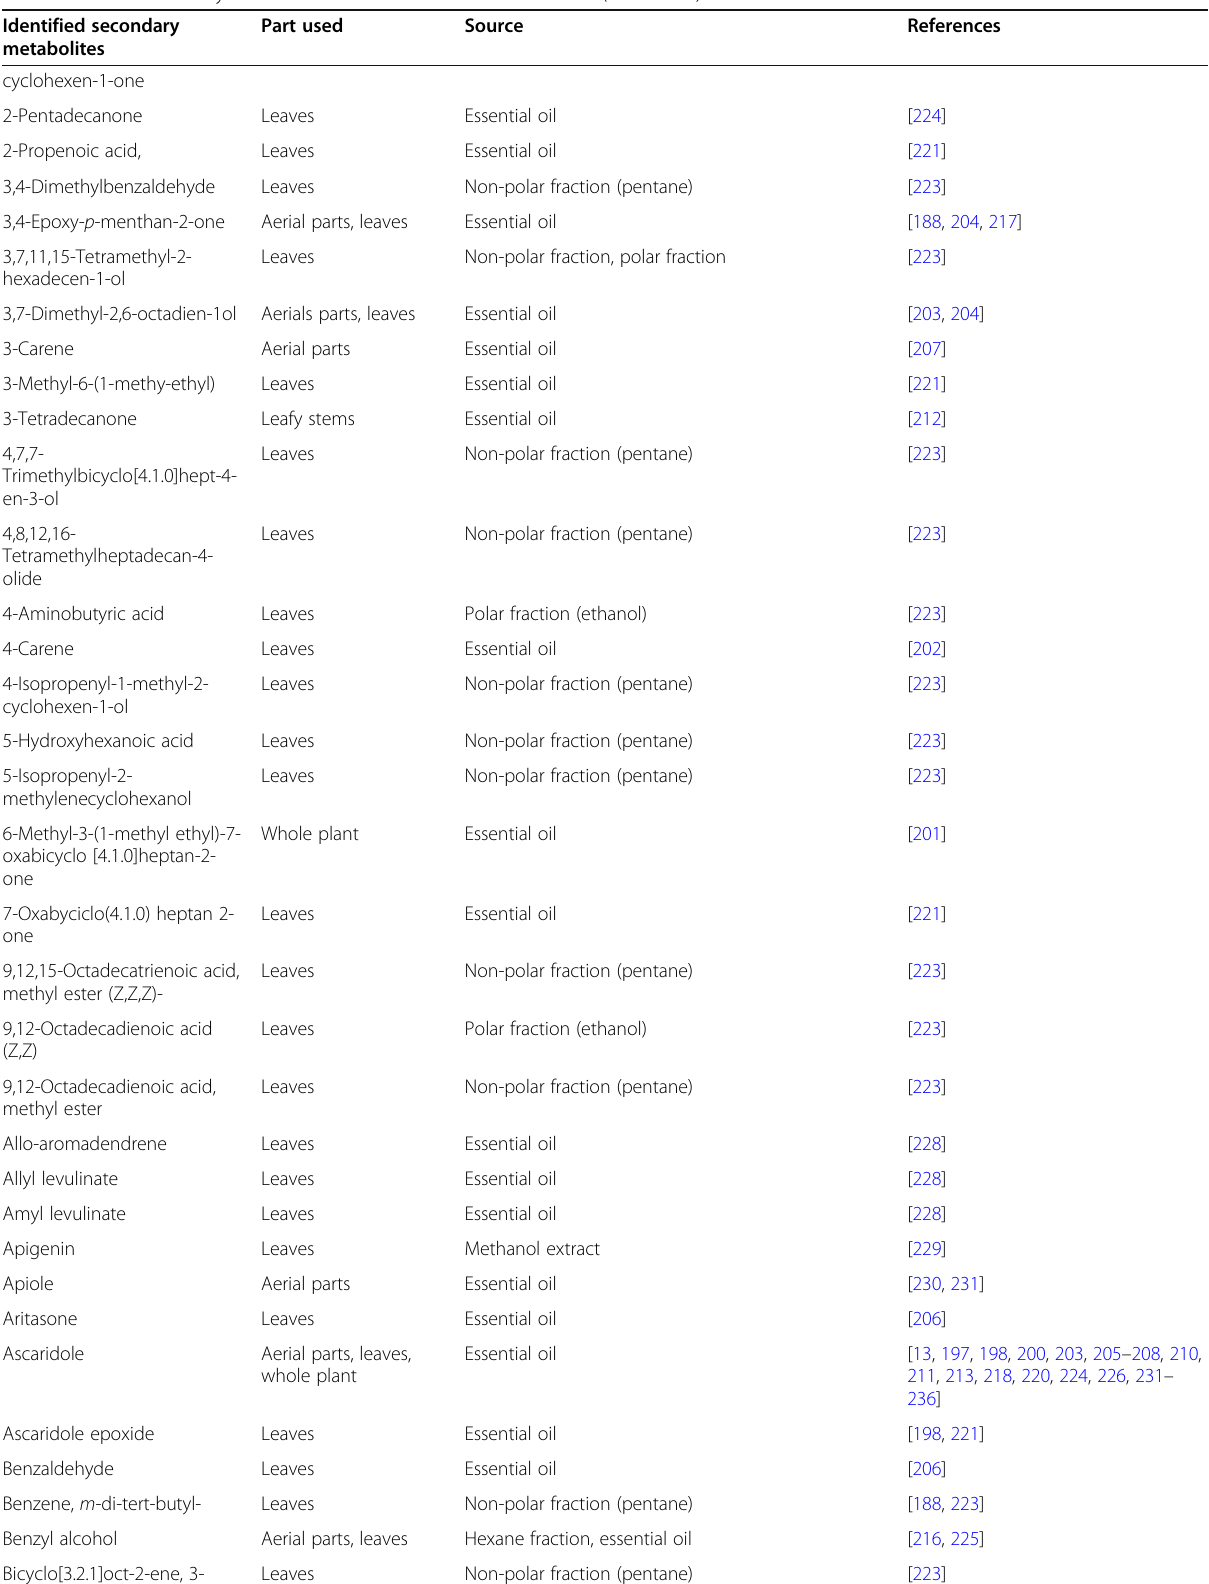
Table 3 Main secondary metabolites identified in C. ambrosioides